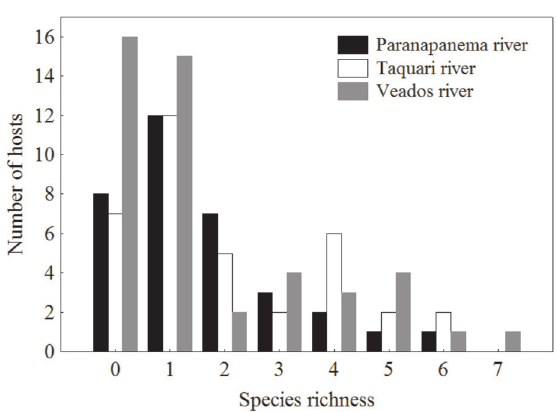
Figure 2 - Distribution of species richness in the parasite infracommunities of Leporinus friderici from three upstream tributaries of Jurumirim reservoir, Upper Paranapanema River, southeast,